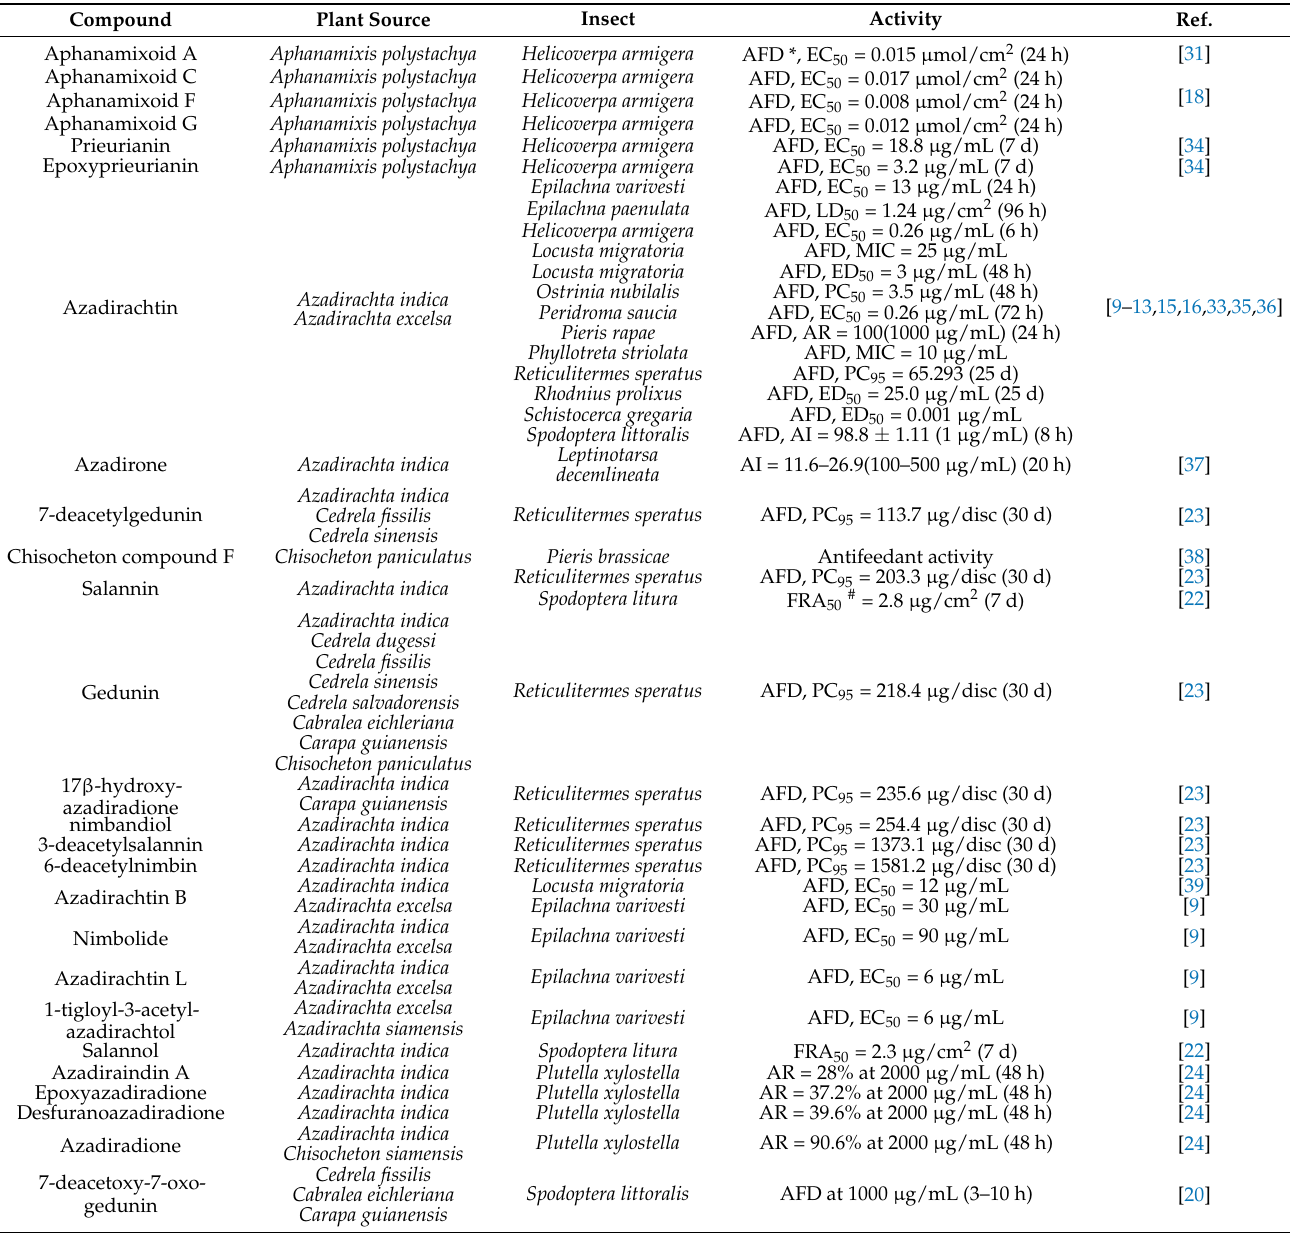
Table 2. Antifeedant activity of insect cidal triterpenoids of plants from 8 genera in Meliaceae. Compound